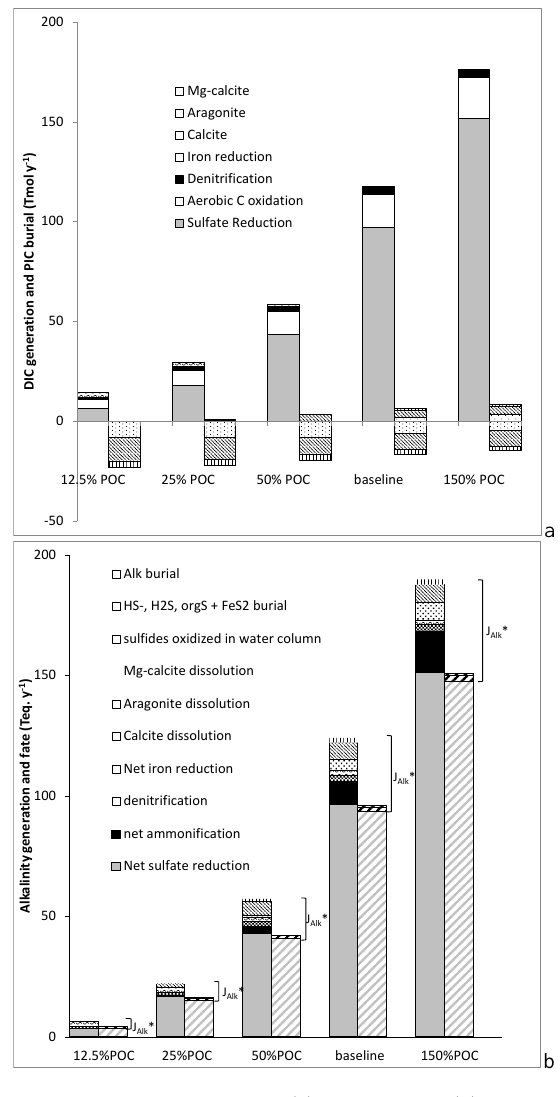
Fig. 5. Global generation of DIC (a) and alkalinity (b) , along with the fate of generated alkalinity and PIC. Baseline coastal benthic POC deposition fluxes. (a) first column is DIC generation by C oxi- dation pathway; second column is PIC dissolution or burial. (b) first column is alkalinity generation by redox reactions and PIC dissolu- tion; second column is the fate of the liberated alkalinity (burial, release to the water column as J Alk ∗ , release to the water column as sulfides). Alkalinity sink due to PIC burial is also indicated.